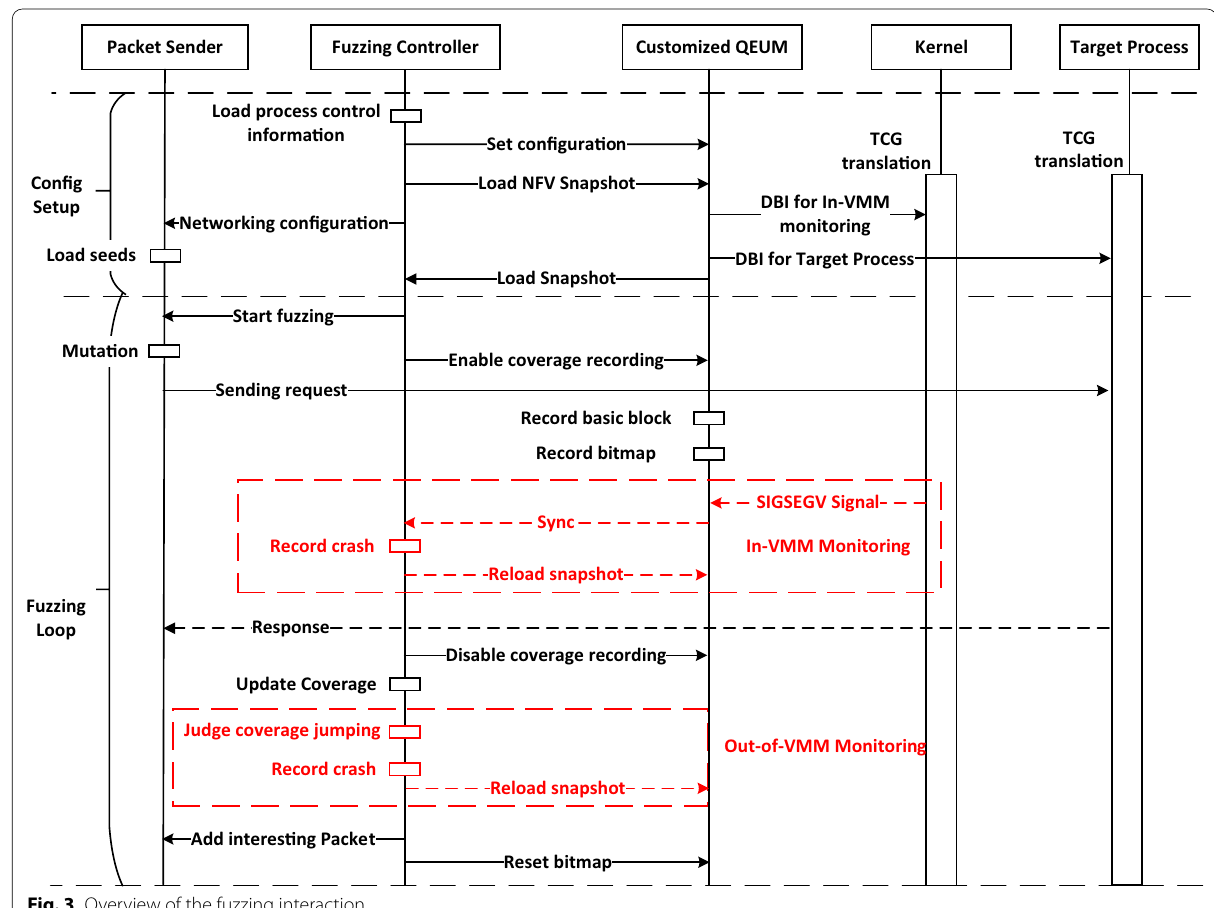
Fig. 3 Overview of the fuzzing